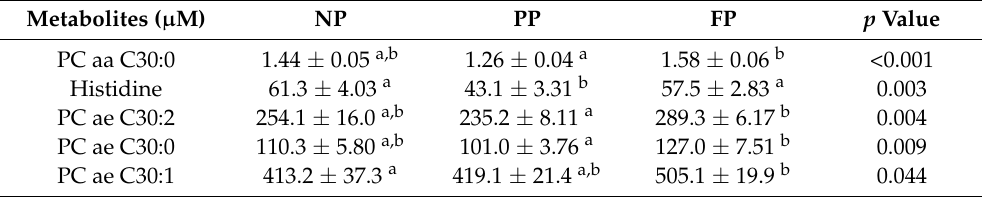
Table 1. Mean concentration of significant metabolites ± standard error of the mean for cows in early-gestation (initial period, before receiving the treatments) with their respective p values.